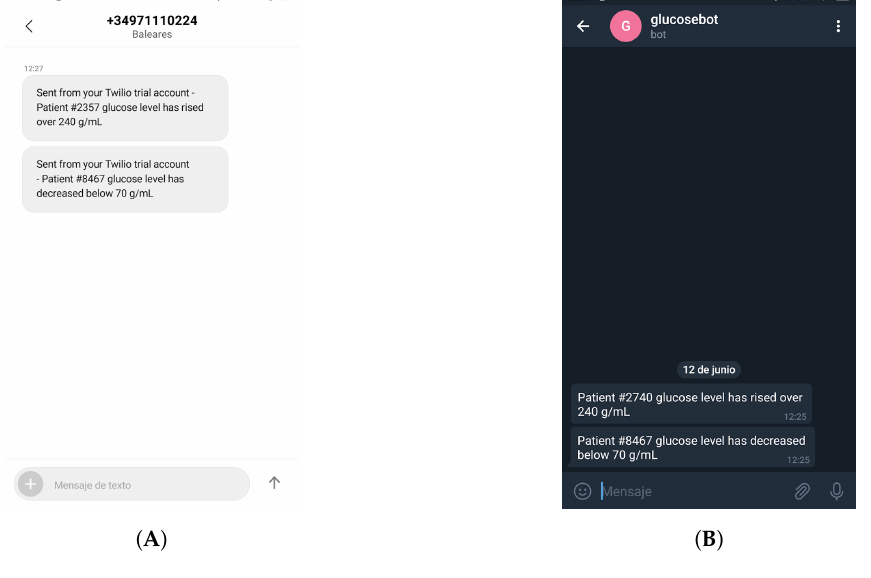
Figure 5. Event notifications received through a Twilio’s SMS ( A ) and a Telegram message ( B